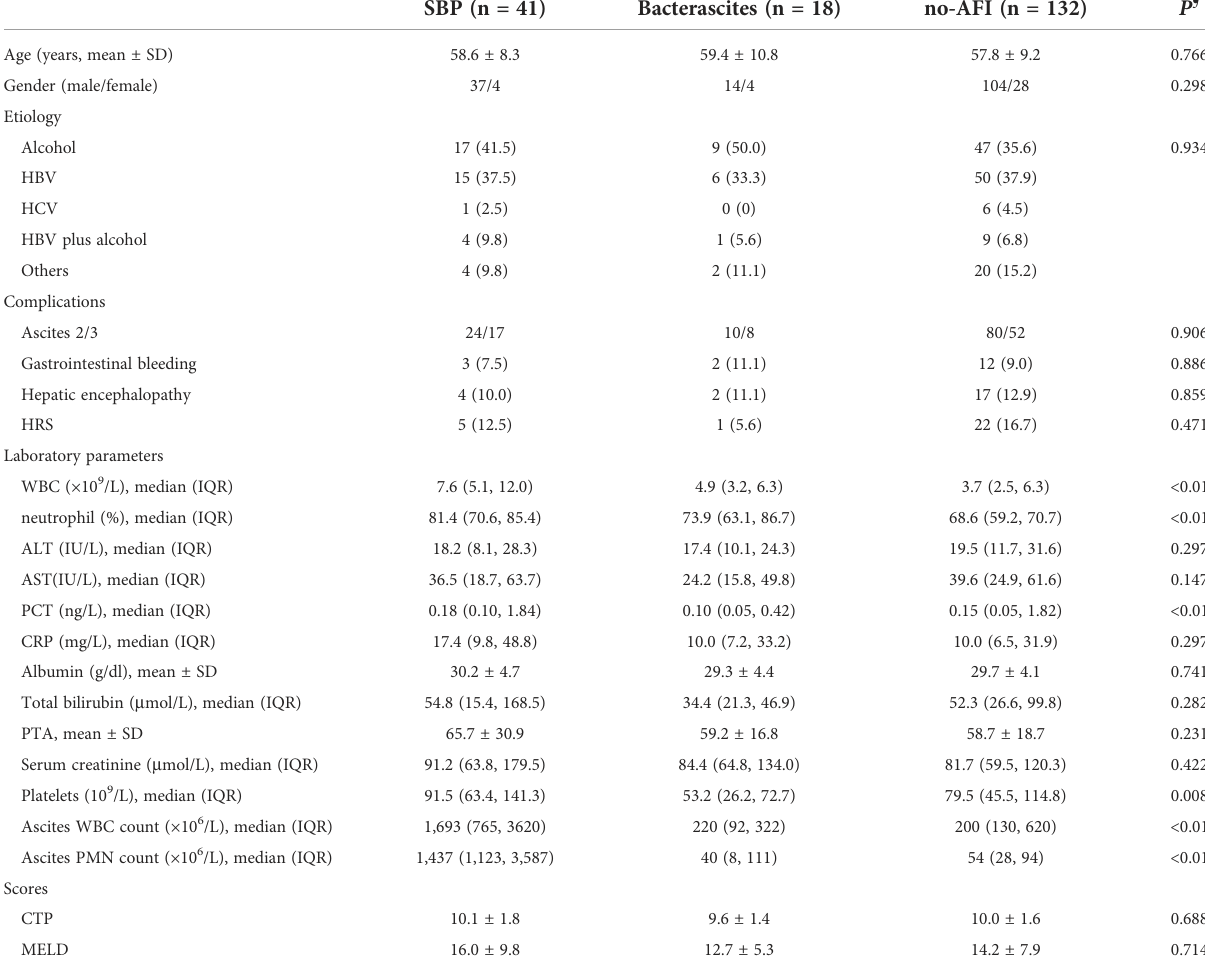
TABLE 1 Clinical characteristics of enrolled